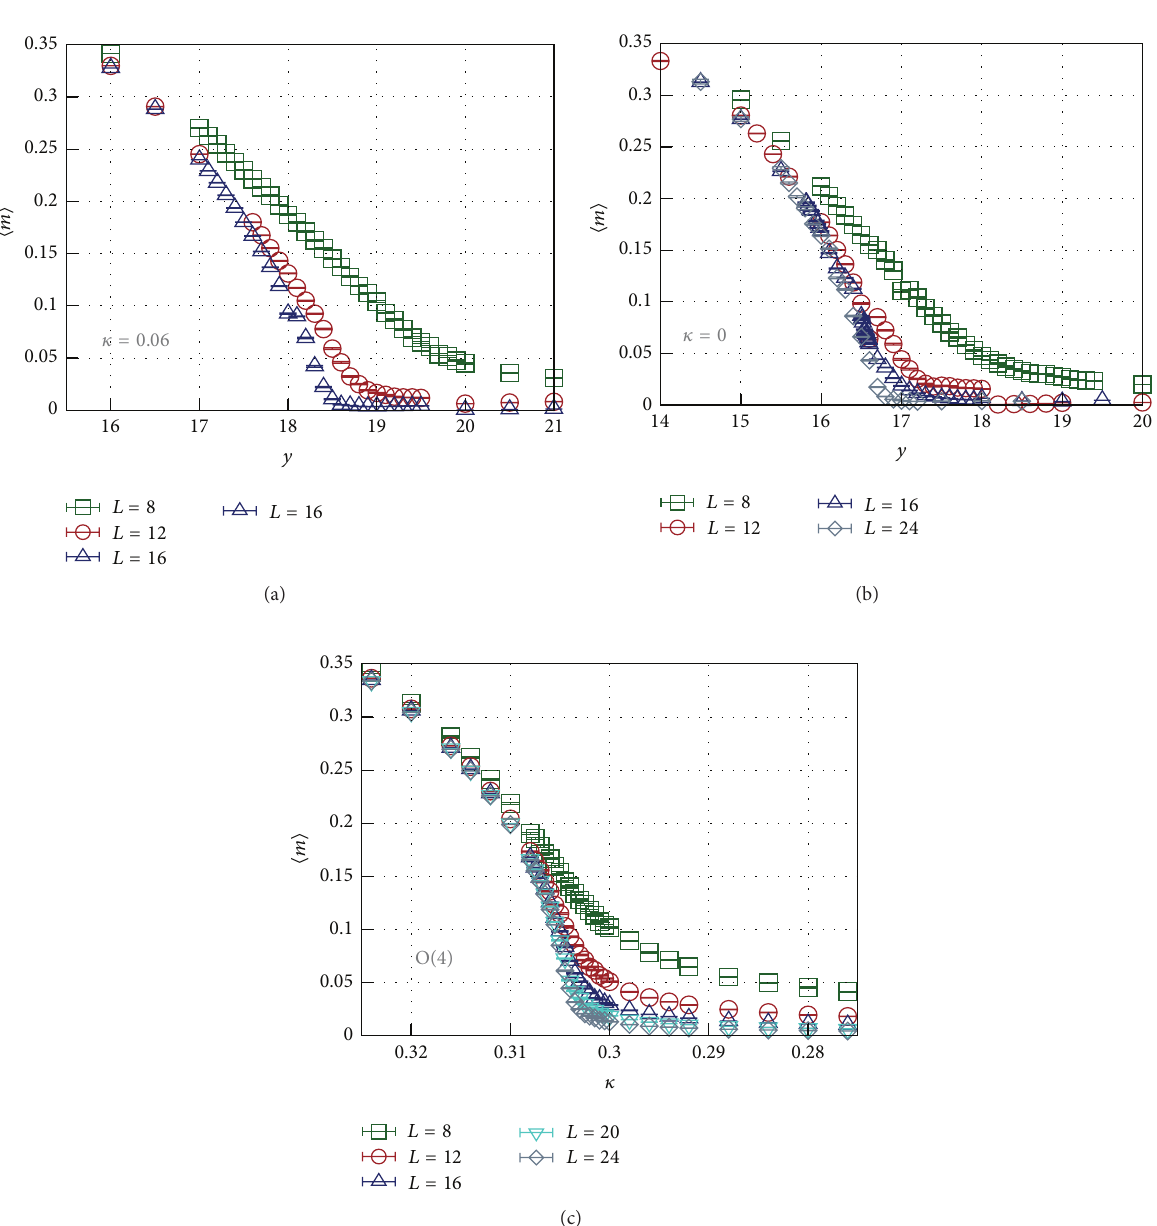
Figure 7: Magnetisation, ⟨𝑚⟩ , for the Higgs-Yukawa model at 𝜅 = 0.06 (a), 𝜅 = 0.00 (b), and the pure O(4) model (c) for various volumes. For the O(4) ⟨𝑚⟩ is plotted as a function of decreasing 𝜅 to match optically with the Higgs-Yukawa model. The absence of discontinuities in ⟨𝑚⟩ is an evidence for a second-order phase